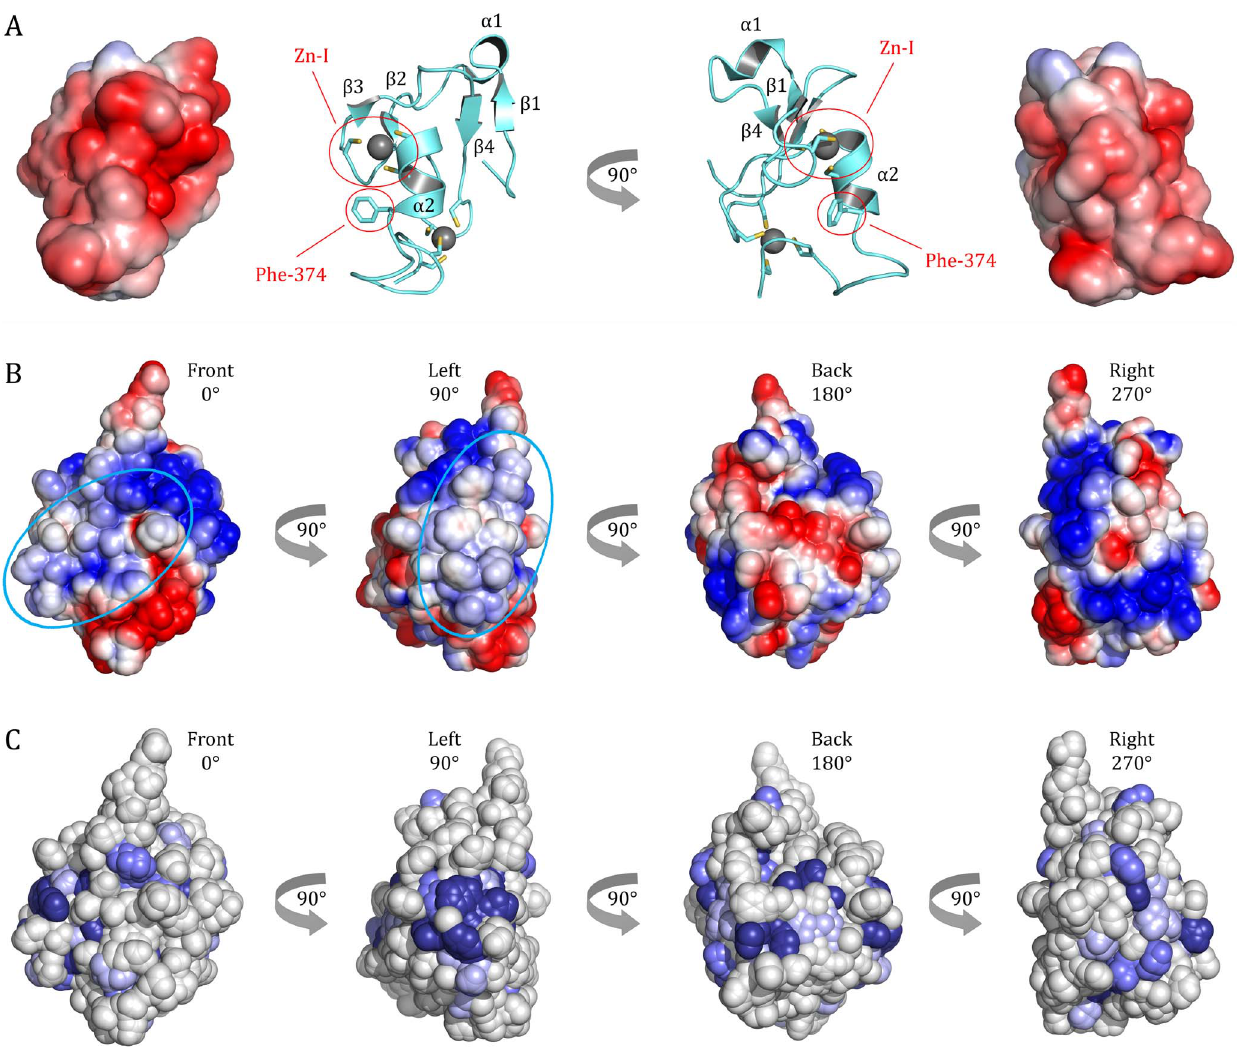
Figure 5. Potential binding sites for the TFIIH p44 subunit. (A) A structure of the human C-terminal domain of p44 (1Z60) is shown as a cartoon model and with the electrostatic potential (contoured at 6 3.0 k b T/e c ) mapped onto its surface. The zinc ions bound to the C4C4 motif in p44 are shown in grey and the two regions most likely involved in p34 binding are circled in red. (B) The electrostatic potential contoured at 6 3.0 k b T/e c is mapped onto the p34ct surface (A) in blue (positive), red (negative) and white (neutral) and suggests two putative binding sites for the p44ct C4C4 domain (circled in cyan). (C) The conservation of surface residues in the p34ct vWA domain is depicted, with the different shades of blue reflecting the variable degree of conservation, in analogy to the color code used in Figure